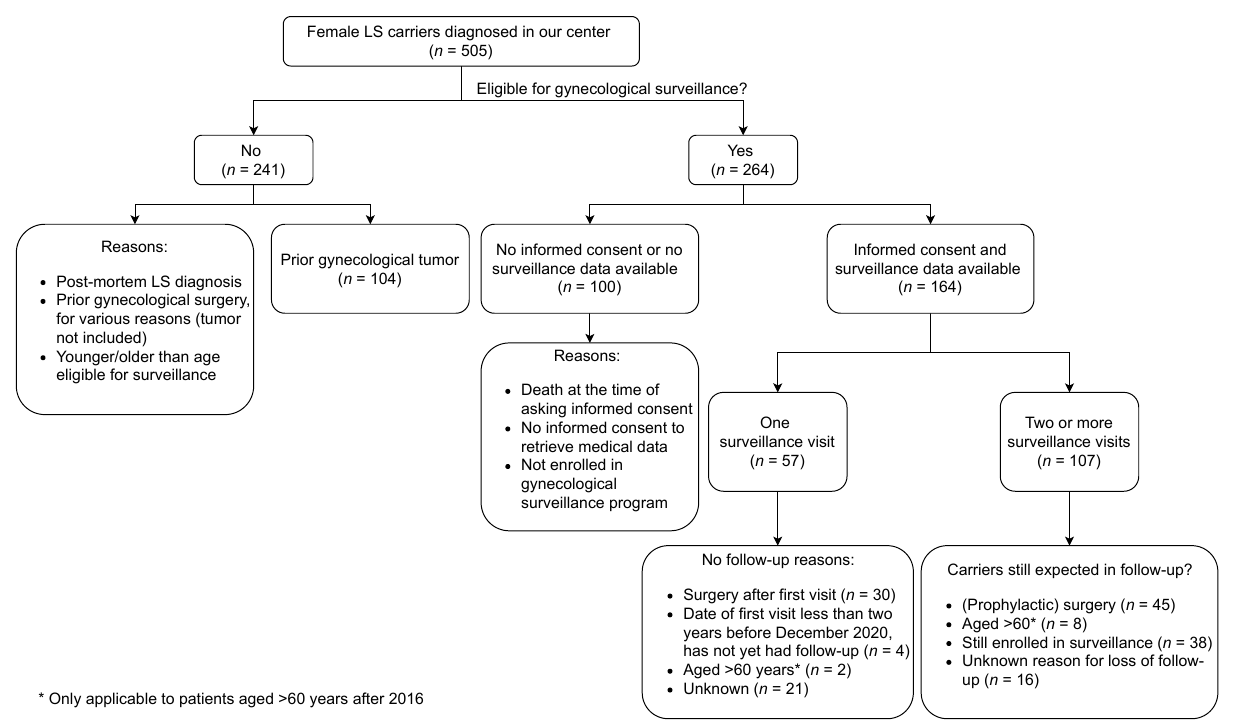
Figure 1. Overview of female Lynch syndrome (LS)